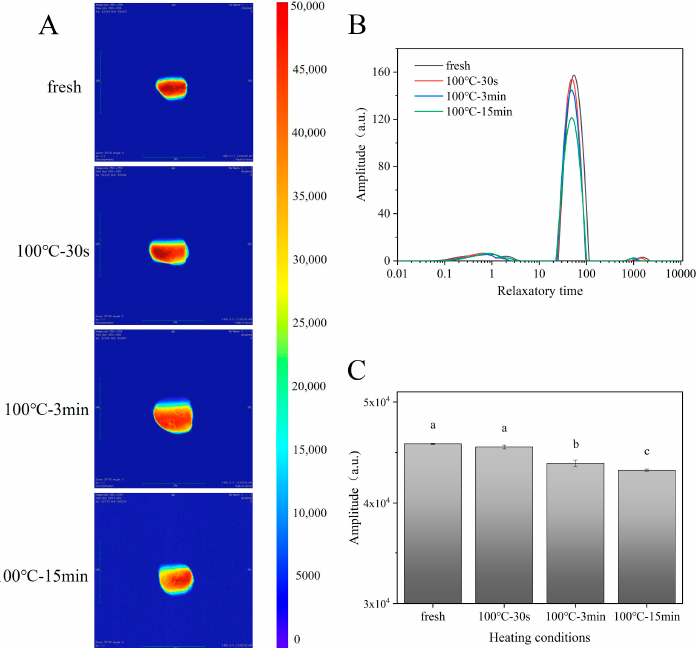
Figure 5. Changes in water-weighted magnetic resonance images (MRI). ( A ) T 2 relaxation time; ( B ) the quantitative signal intensity of MRI ( C ) of SAM after boiling. 100 °C–30 s, 30-s-boiled sample; 100 °C–3 min, 3-min-boiled sample; 100 °C–15 min, 15-min-boiled sample; values with different superscript letters indicate significant differences at the level of p < 0.05.